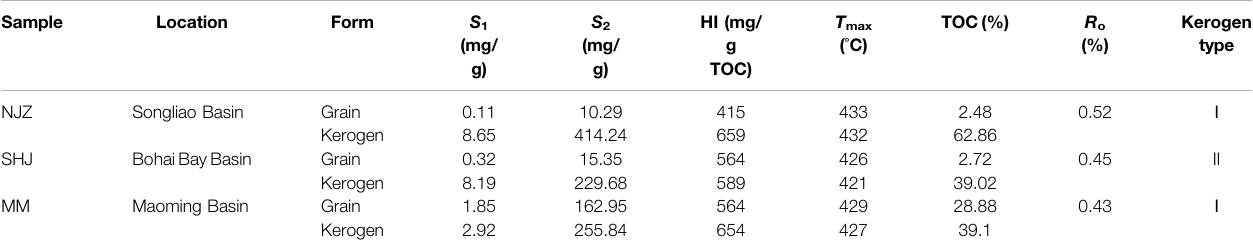
TABLE 1 | Geochemical data for samples used in the pyrolysis study.